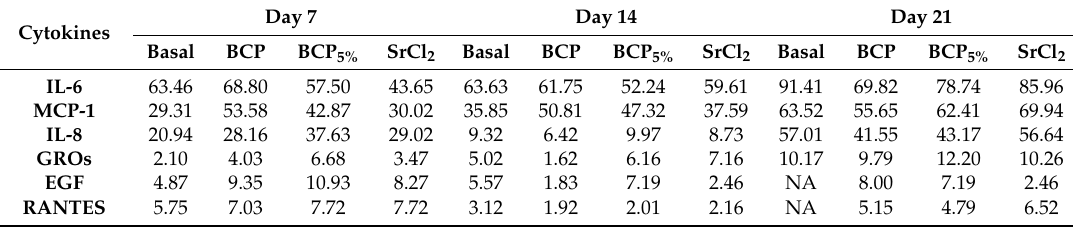
Table 2. Average values of cytokine production in human primary bone cell culture supernatants in BCP, BCP 5% , and SrCl2-stimulated conditions measured by antibody arrays. NA means not achievable. Day Cytokines